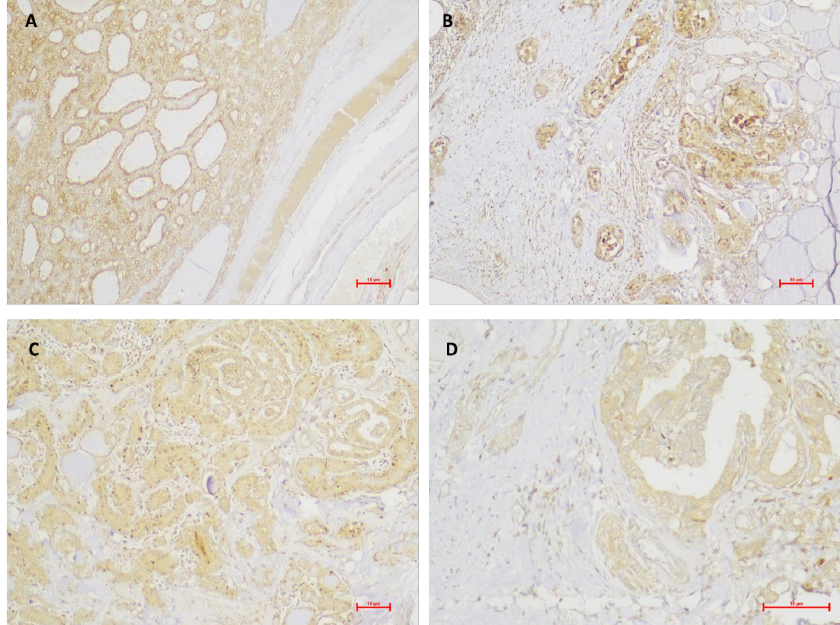
Figure 2. Photomicrographs of the immunohistochemical staining of NP-1 (stained in brown) in the different studied groups. Different groups had the same staining intensity (score 2). ( A ), Benign neoplasm (original magnification × 100); ( B ), PTC + 0 (original magnification × 100); ( C ), PTC + E, (original magnification × 100); ( D ), PTC + M, (original magnification × 200).